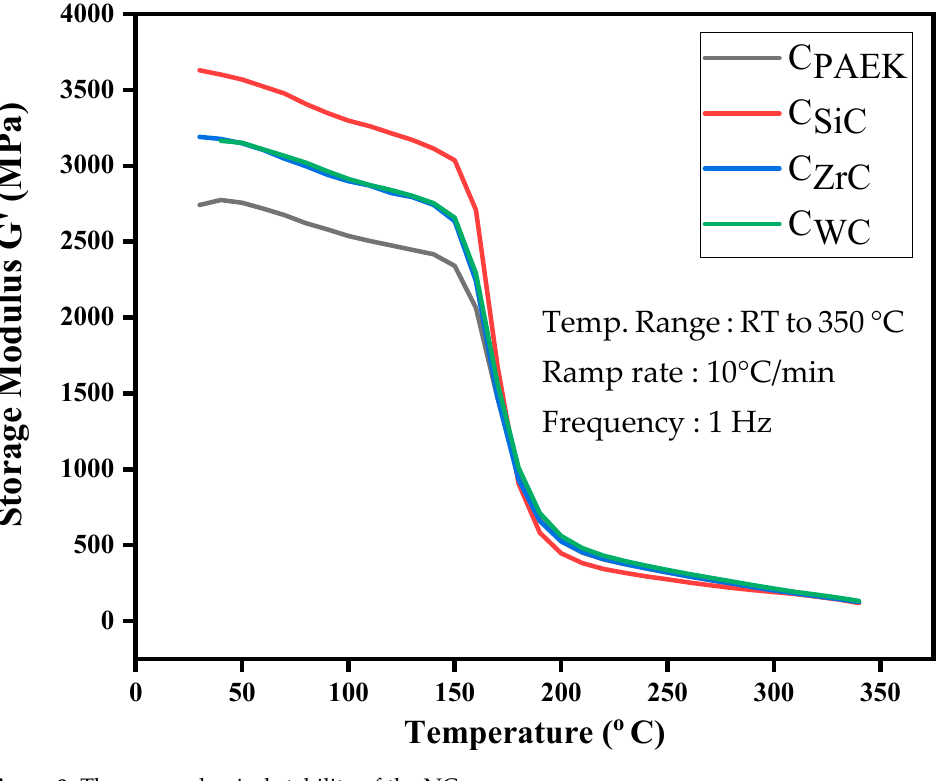
Figure 8. Thermomechanical stability of the NCs. Table 5. Storage modulus of developed NCs.